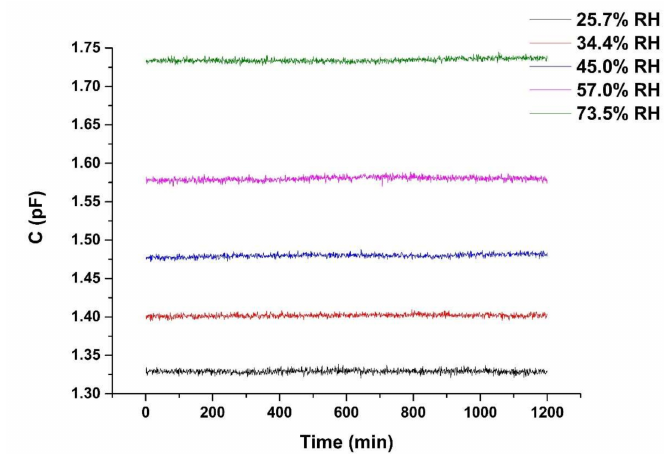
Figure 10. Stability of SIDE sensor. The sensor is kept in the incubator for 1200 min at 25.7% ± 0.8%, 34.4% ± 0.8%, 45.0% ± 0.8%, 57.0% ± 0.8%, and 73.5% ± 0.8% RH,